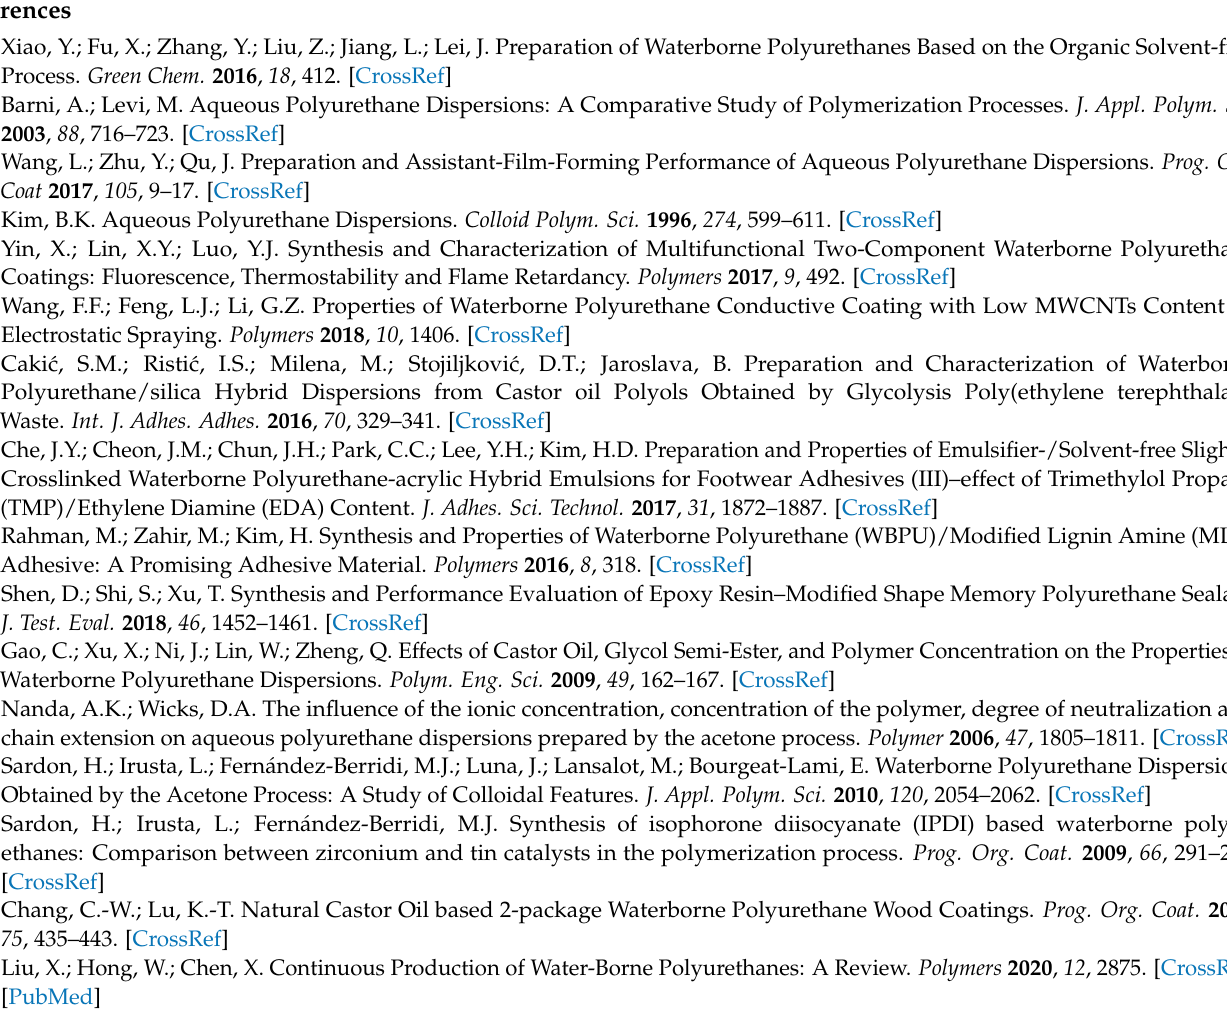
Table S1: Sample designations of WPUR dispersions; Table S2: Preparation and properties of WPUR dispersions with different adding emulsification water method; Table S3: Preparation and prop- erties of WPUR dispersions with different temperatures of prepolymer and emulsification water; Table S4: Preparation and properties of WPUR dispersions with different concentrations of the chain-extended